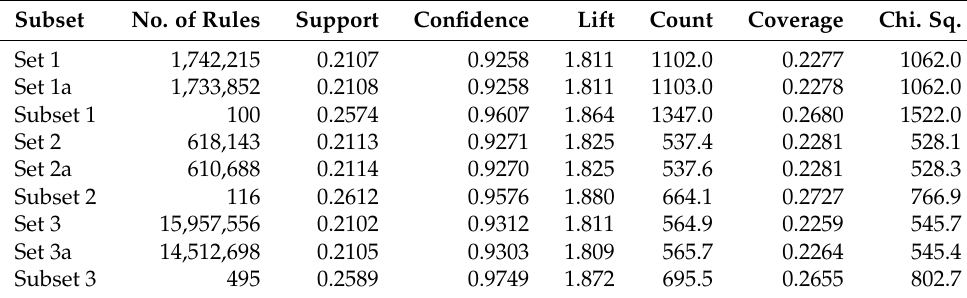
Table 1. Summary of measures’ rules for all subsets of each